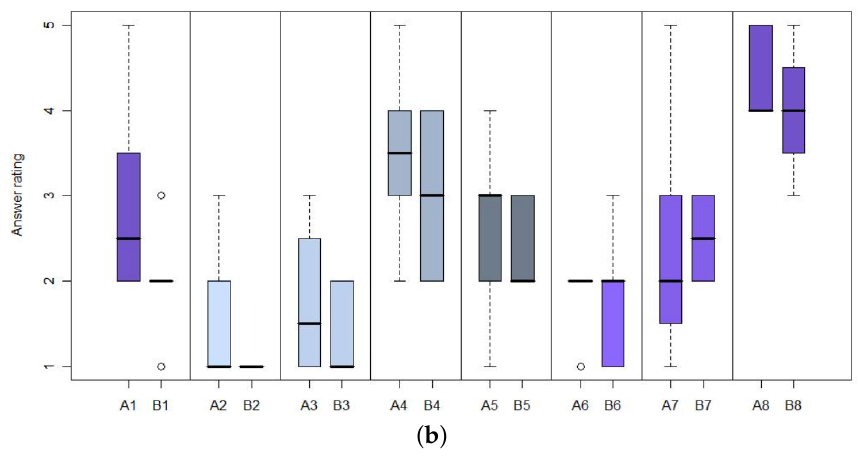
Figure 15. Distribution of answers to Questionnaire 1 by group: task t1 ( a ) and task t2 ( b ).